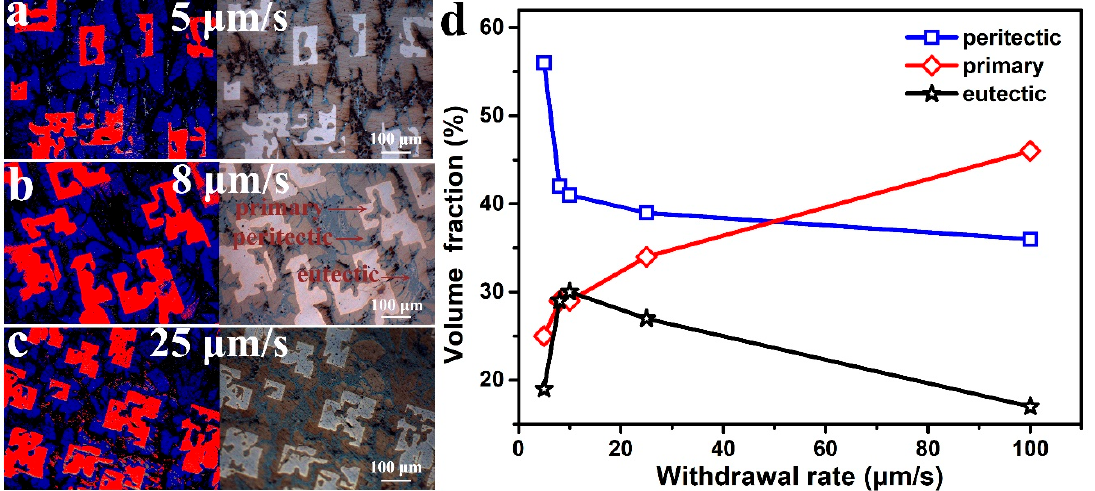
Figure 3. The CuCe alloy transverse microstructure image and staining picture. ( a ) 5 µ m / s, ( b ) 8 µ m / s, ( c ) 25 µ m / s. ( d ) Volume fraction of each phase.